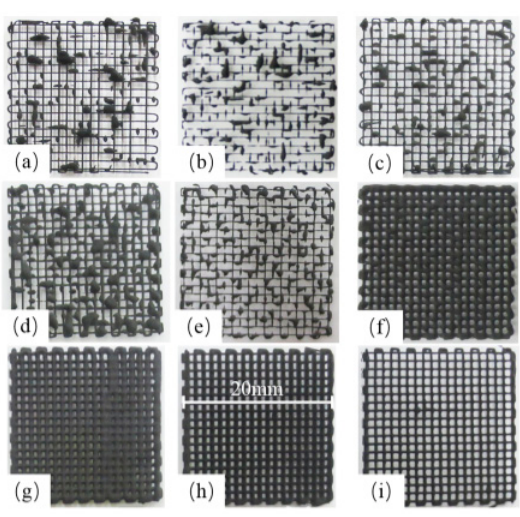
Figure 4. Images of printed LFP grid patterns using different printing parameters. ( a ) v j = 0.003 mm/s,